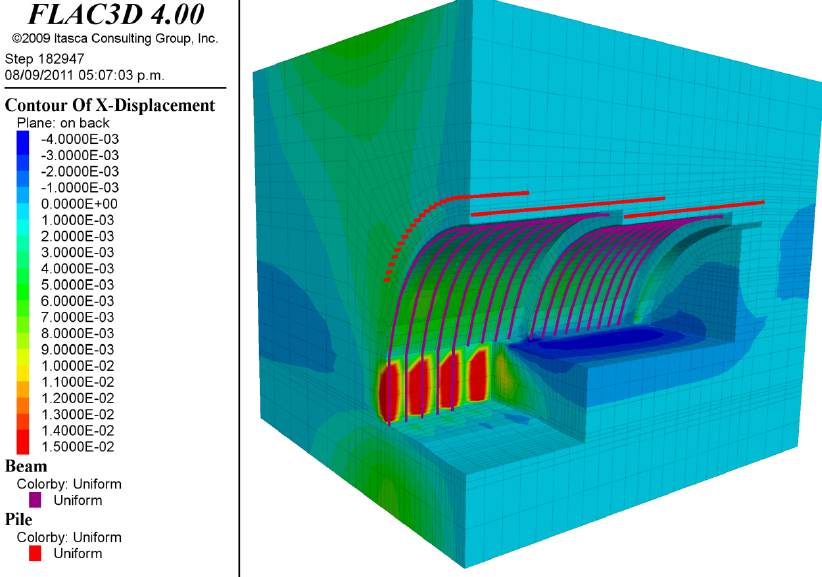
Figure 9. Horizontal displacements (Ux in meters) in an intermediate stage of the excavation. Minimum parameters [12].